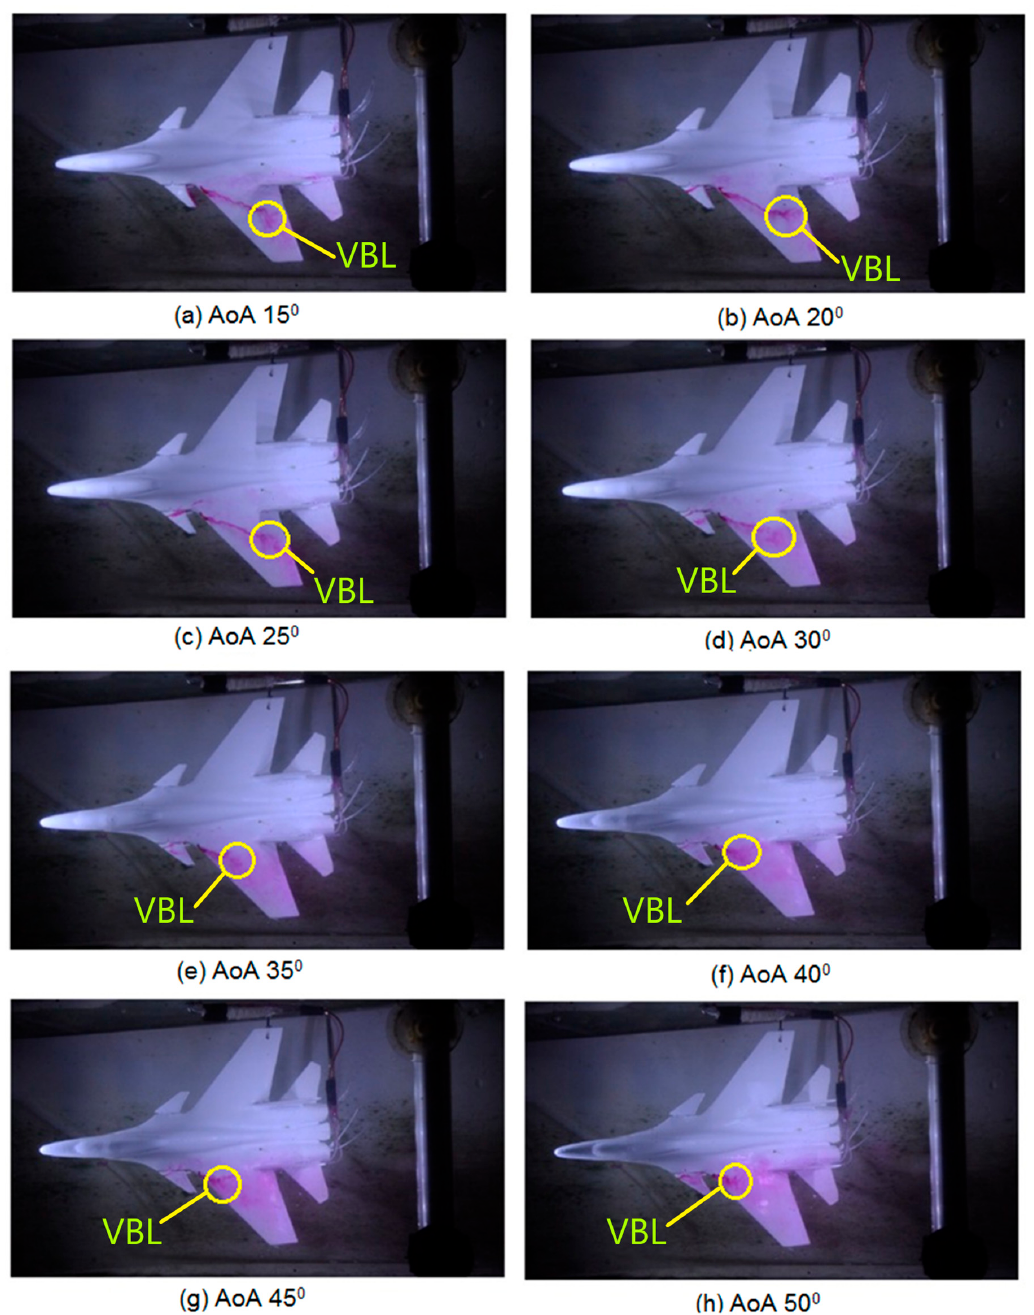
Figure 3. Flow visualization of vortex core stream with canard δ = 20° deflection angle, using water tunnel. water